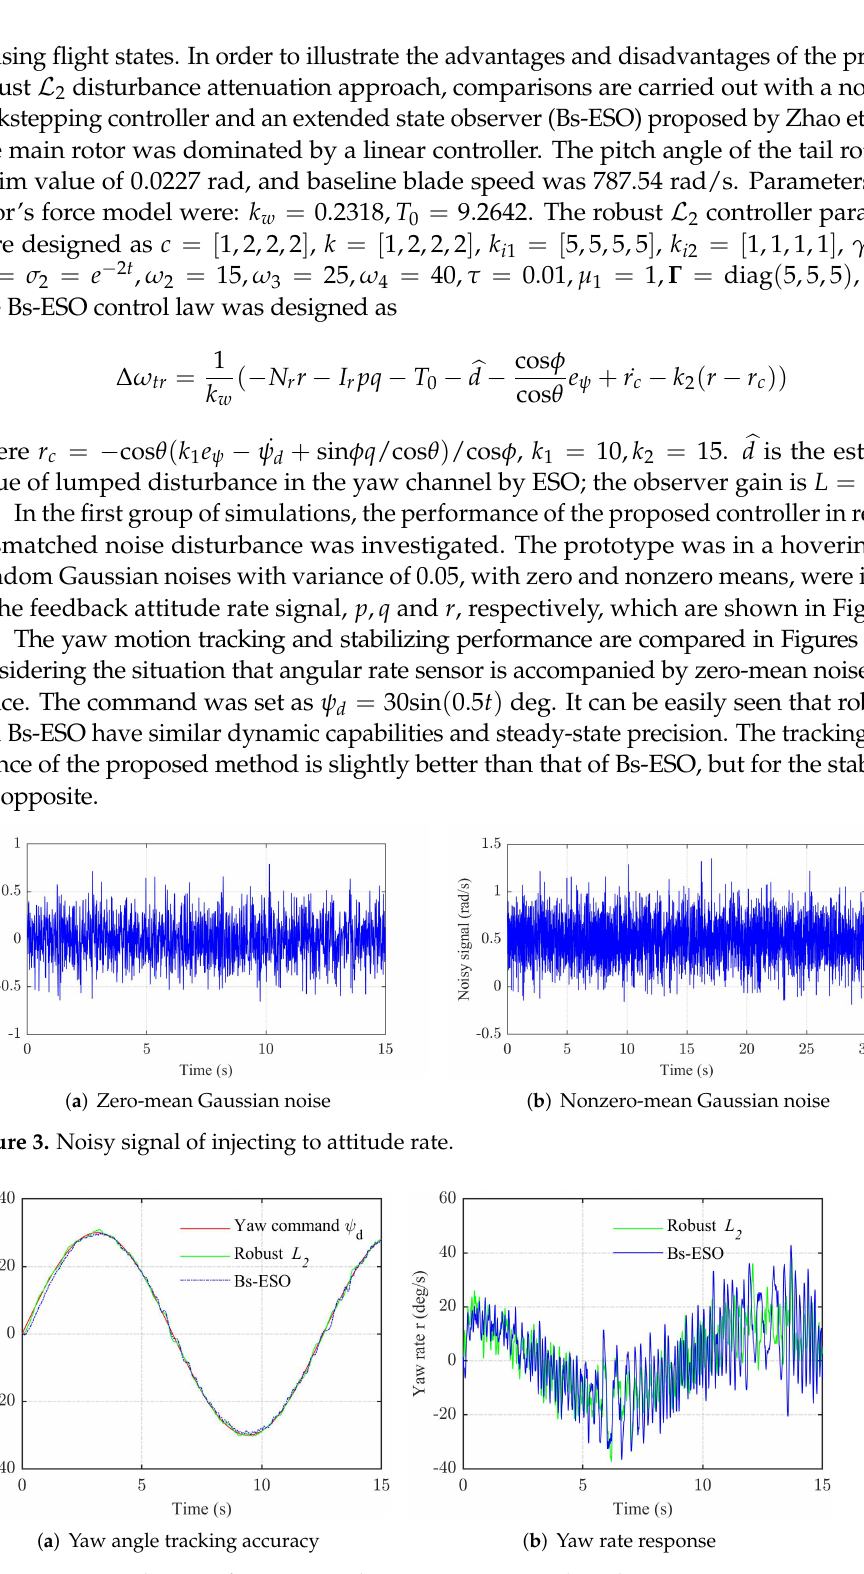
Figure 4. Yaw tracking performance under zero-mean noise